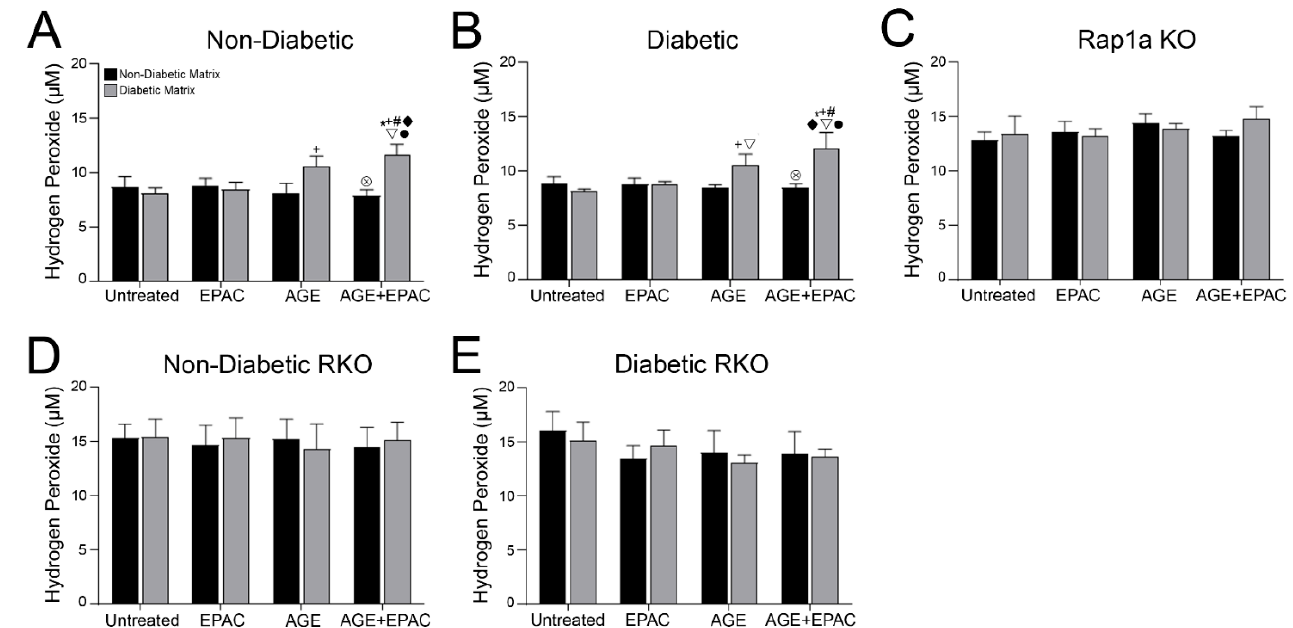
Figure 8. AGE/RAGE signaling and Rap1a expression impacted hydrogen peroxide levels in cardiac fibroblasts. Cardiac fibroblasts isolated from ( A ) non-diabetic, ( B ) diabetic, ( C ) Rap1a KO, ( D ) non-diabetic RKO, and ( E ) diabetic RKO mouse hearts. Fibroblasts were embedded in non-diabetic (black bars) and diabetic (grey bars) matrices for 7 days and treated with EPAC (100 μ M), exogenous AGEs (0.05 mg/mL) and EPAC+exogenous AGEs (100 μ M and 0.05 mg/mL, respectively). Protein lysates were collected and assessed for hydrogen peroxide concentration. Mean ± SEM were graphed with n = 5–10 and statistical analysis consisted of a two-way ANOVA, followed by a Fisher’s Least Significant Difference post hoc. Symbols above each bar indicate significance between a specific group ( p < 0.05; * vs. untreated in non-db, + vs. untreated in db, # vs. EPAC in non-db, (cid:117) vs. EPAC in db, (cid:53) vs. AGE in non-db, ⊗ vs. AGE in db, and • vs. AGE+EPAC in non-db). Untreated treatment groups embedded in non-diabetic collagen were initially presented in Figure 7.